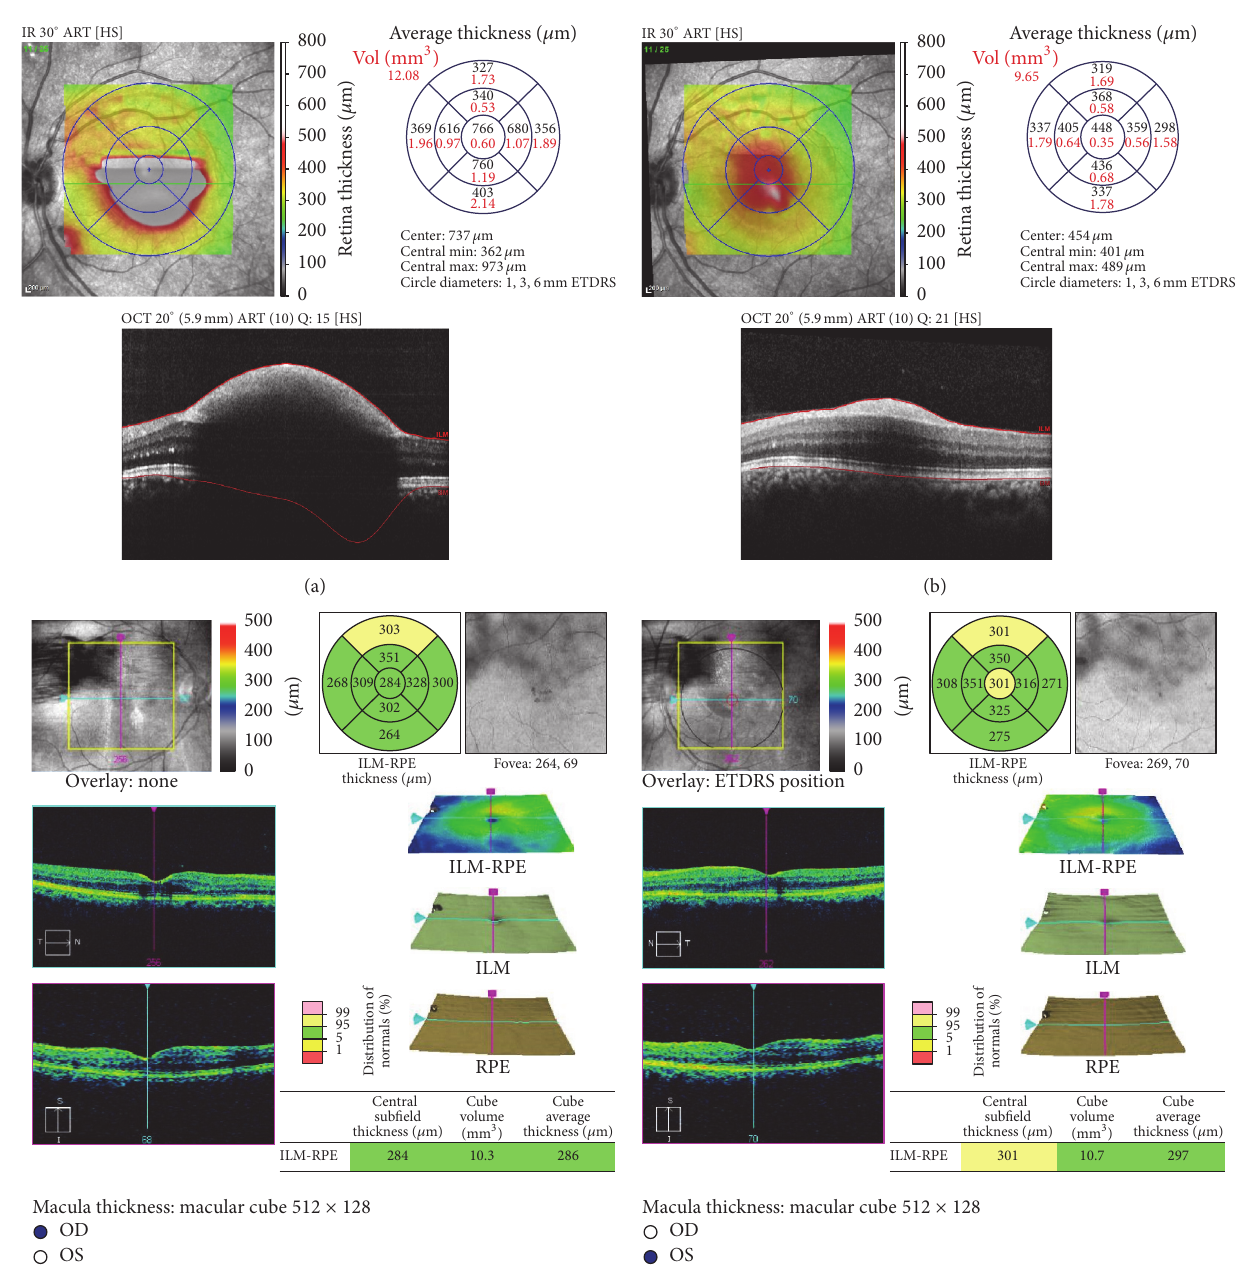
Figure3:Case1.Opticalcoherencetomography(OCT)atinitialpresentationandat6weeksand3monthsafterinitialpresentation.Notes.(a) OCT showed premacular haemorrhage in the left eye at initial presentation. (b) OCT showed partial resolution of premacular haemorrhage in thelefteyeat1monthafterfirstleftintravitrealranibizumab(6weeksafterinitialpresentation).(c)Minimalresidualpremacularhaemorrhage with normal retinal layer in the right eye (c) and left eye (d) at 3 months after initial